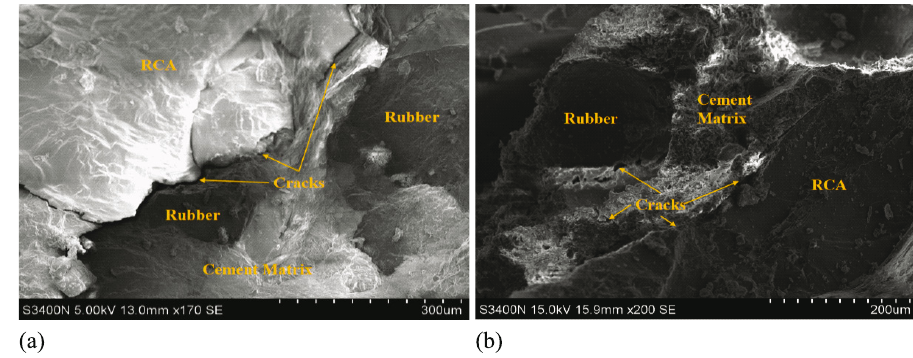
Figure 23: Microstructures of RRAC with simultaneous RCA modi fi cation and rubber modi fi cation treatments ( a and b )